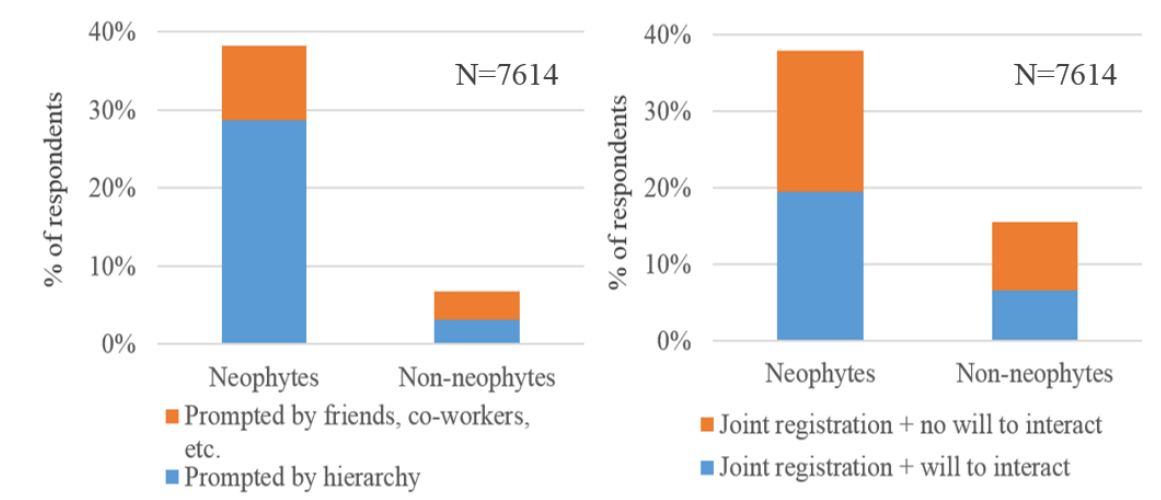
Figure 1. Differences in the interaction pattern between neophytes (who register to a MOOC for the first time) and non-neophytes. Left. Experience in MOOCs and incentives to register. Right. Experience in MOOCs and intention to interact. The exact wording of the questions and answers is provided in the text